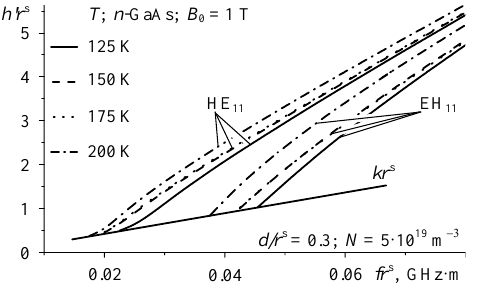
Fig. 7. Wave phase characteristics of models of gyroelectric n -GaAs semiconductor-dielectric waveguides, when d/r s = 0.3; B 0 = 1 T; N = 5·10 19 m –3 .